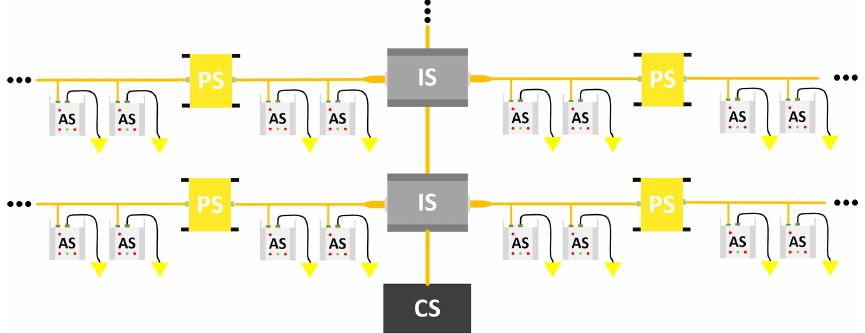
Figure 1. Block diagram of the distributed telemetry data acquisition system. AS, acquisition station; PS, power station; IS, interconnection station; CS, central station.